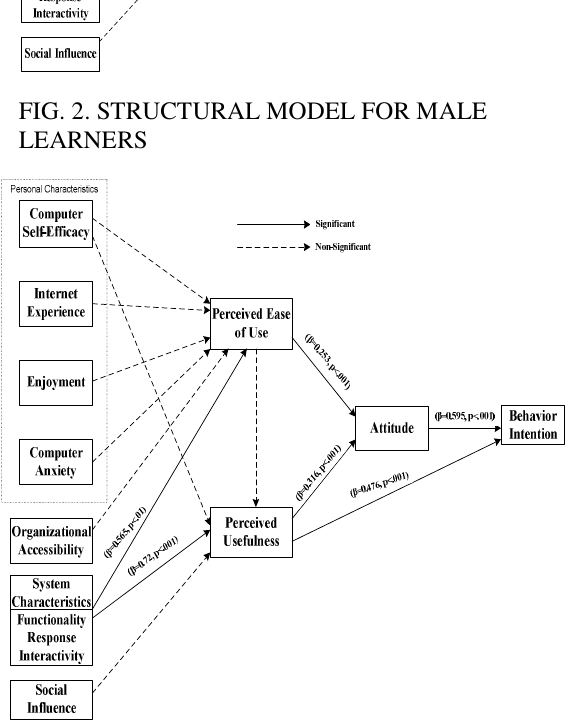
FIG. 5. STRUCTURAL MODEL FOR